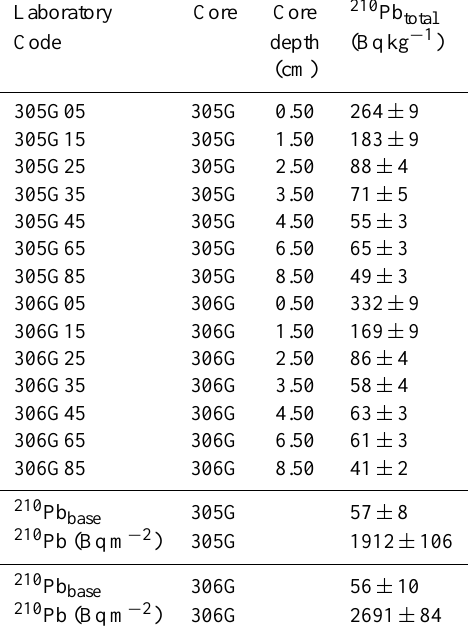
Table 2. Total 210 Pb concentrations and 210 Pb inventories for cores 305G and 306G. Results are reported with a 1 σ